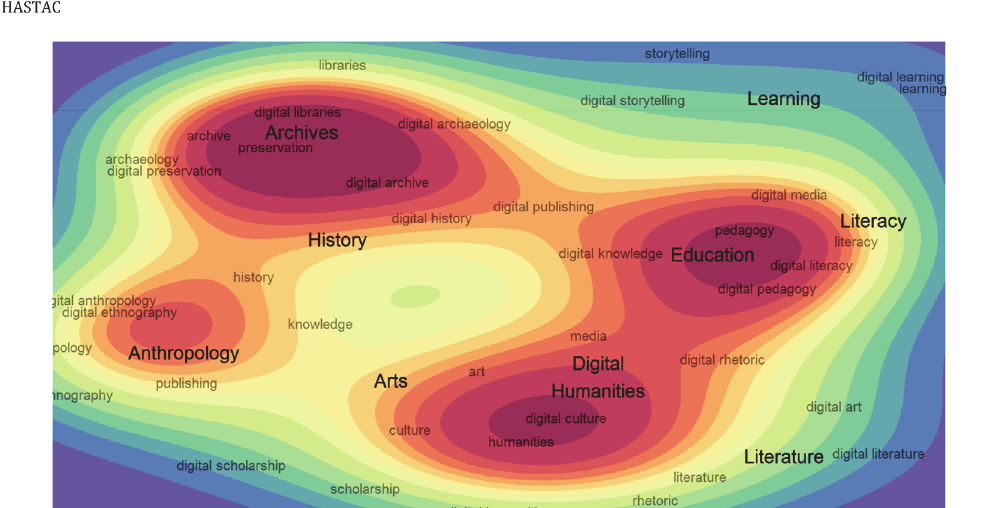
Fig 3. Density curves of log-odds co-occurrence ratios between humanities-related terms. Larger labels represent thematic areas manually identified.